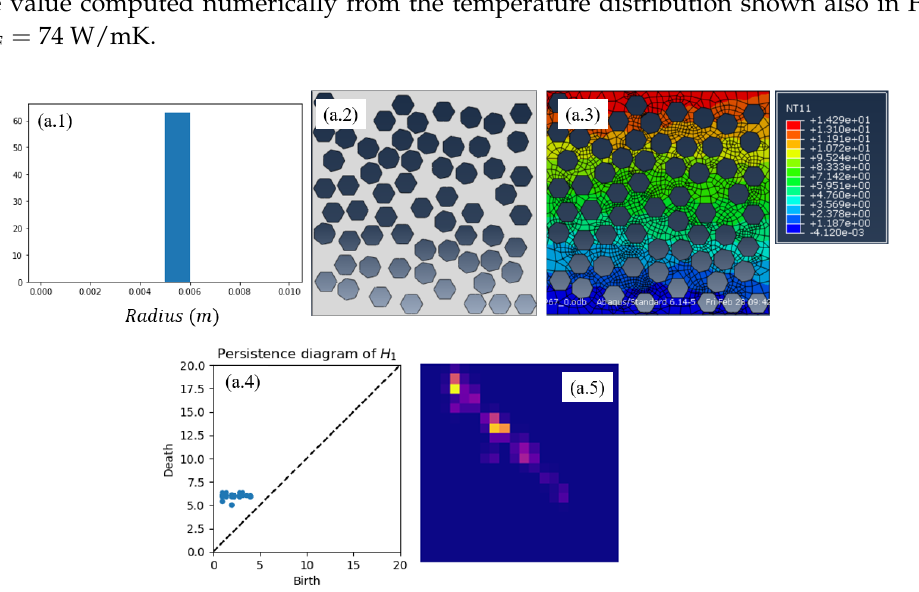
Figure 4. ( a.1 ) Histogram of the pores radius; ( a.2 ) considered microstructure; ( a.3 ) temperature field used for computing the effective thermal conductivity that will serve as reference for evaluating the regression performance; ( a.4 ) persistence diagram; and ( a.5 ) persistence image.